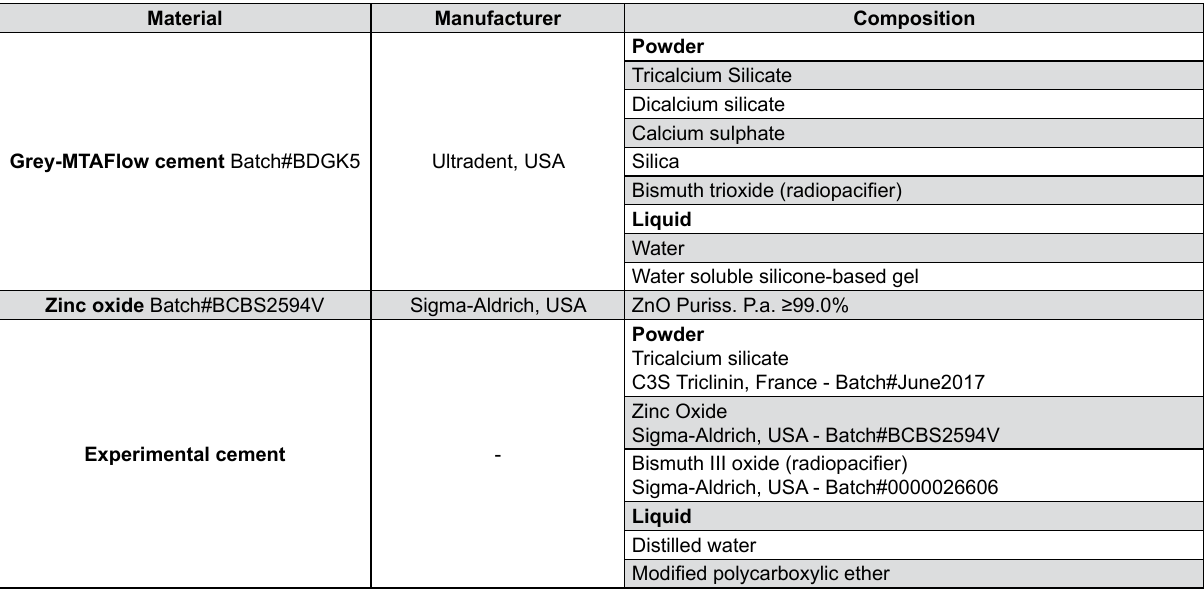
Figure 1- Composition and batch of the materials used in the